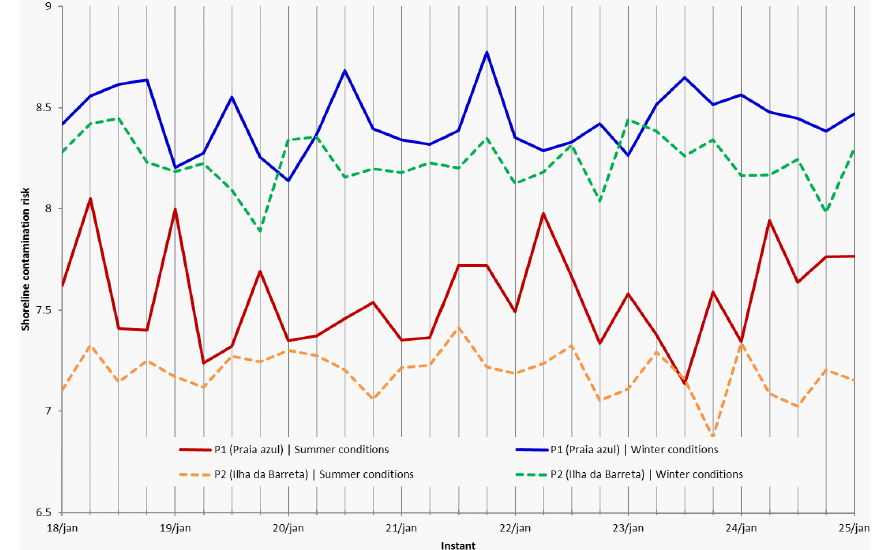
Figure 12. Integrated shoreline contamination risk for the whole pilot area, with AIS vessel information between 18 and 25 January 2013, and using different space and time constant metocean conditions. Winter/rough conditions: surface current velocity, 0.55ms − 1 ; wind velocity, 15ms − 1 ; significant wave height, 3m. Summer/calm conditions: surface current velocity, 0.25ms − 1 ; wind velocity, 5ms − 1 ; significant wave height,